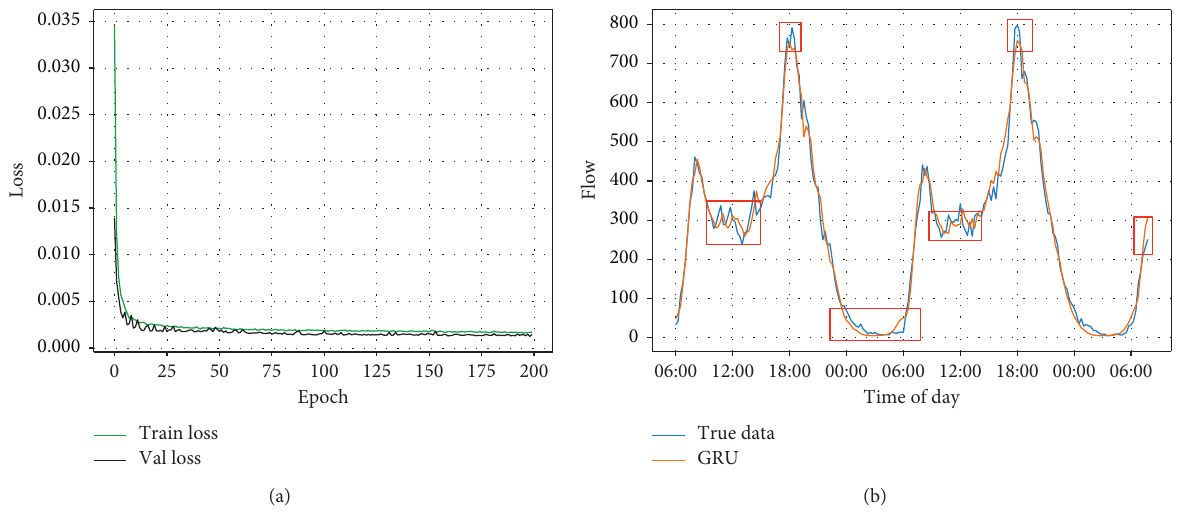
Figure 21: GRU training and prediction. (a) GRU loss function and (b) GRU prediction results.